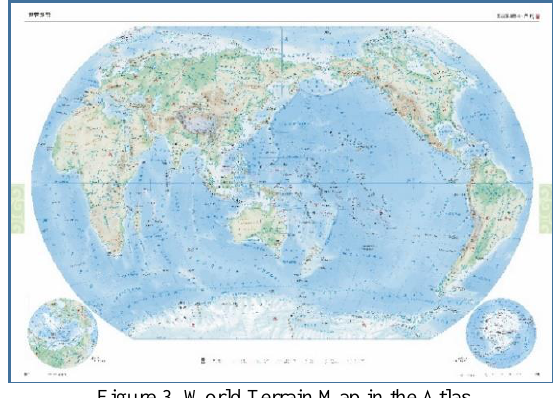
Figure 3. World Terrain Map in the Atlas China map: Terrain map of China highlights the natural geographical elements such as topography, rivers and mountains, simply shows human geographical elements as auxiliary information, as shown in Figure 4.